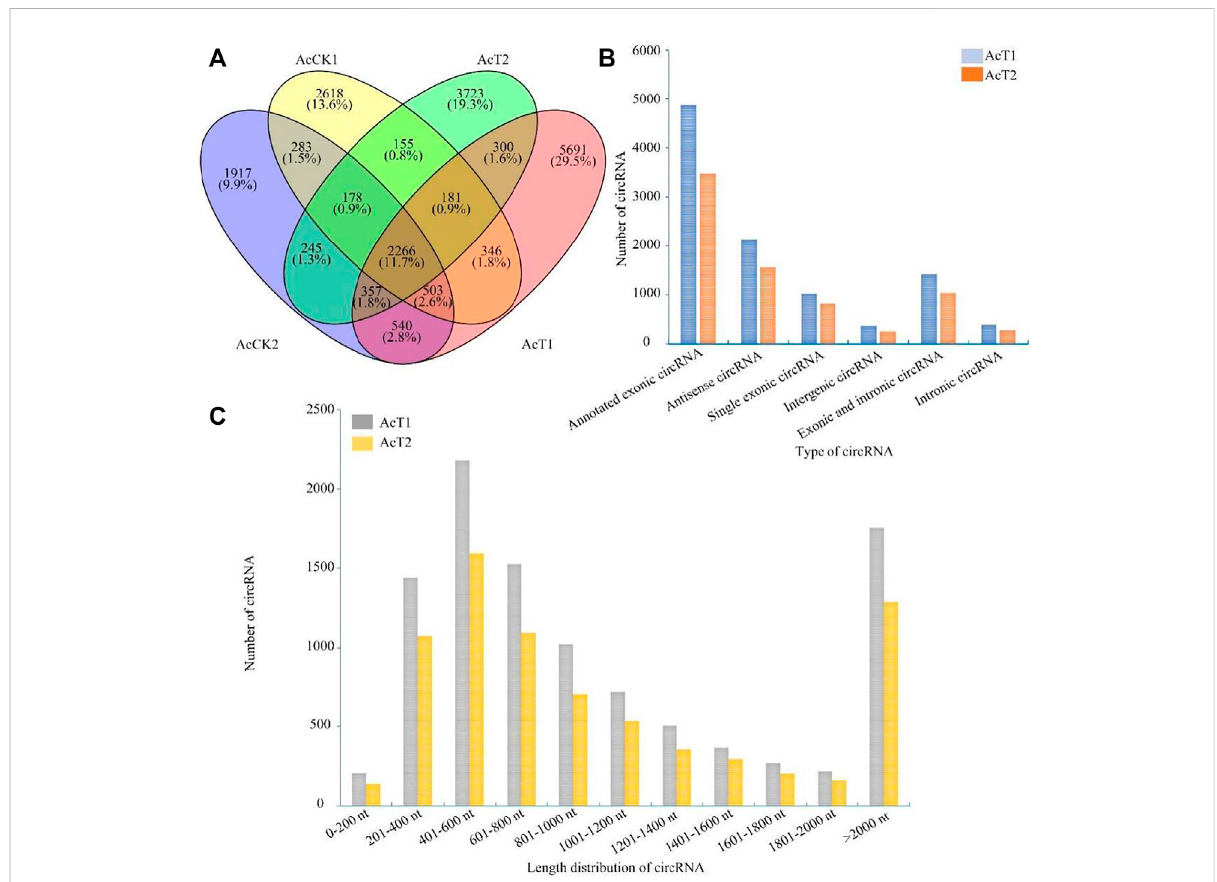
FIGURE 1 Number, type, and length distribution of circRNAs in the midguts of A. c. cerana workers inoculated with N. ceranae . (A) Venn diagram of circRNAsinAcCK1,AcCK2,AcT1,andAcT2groups. (B) NumberstatisticsofcircRNAsderivedfromvariousgenomicorigins. (C) Lengthdistributionof circRNAs.